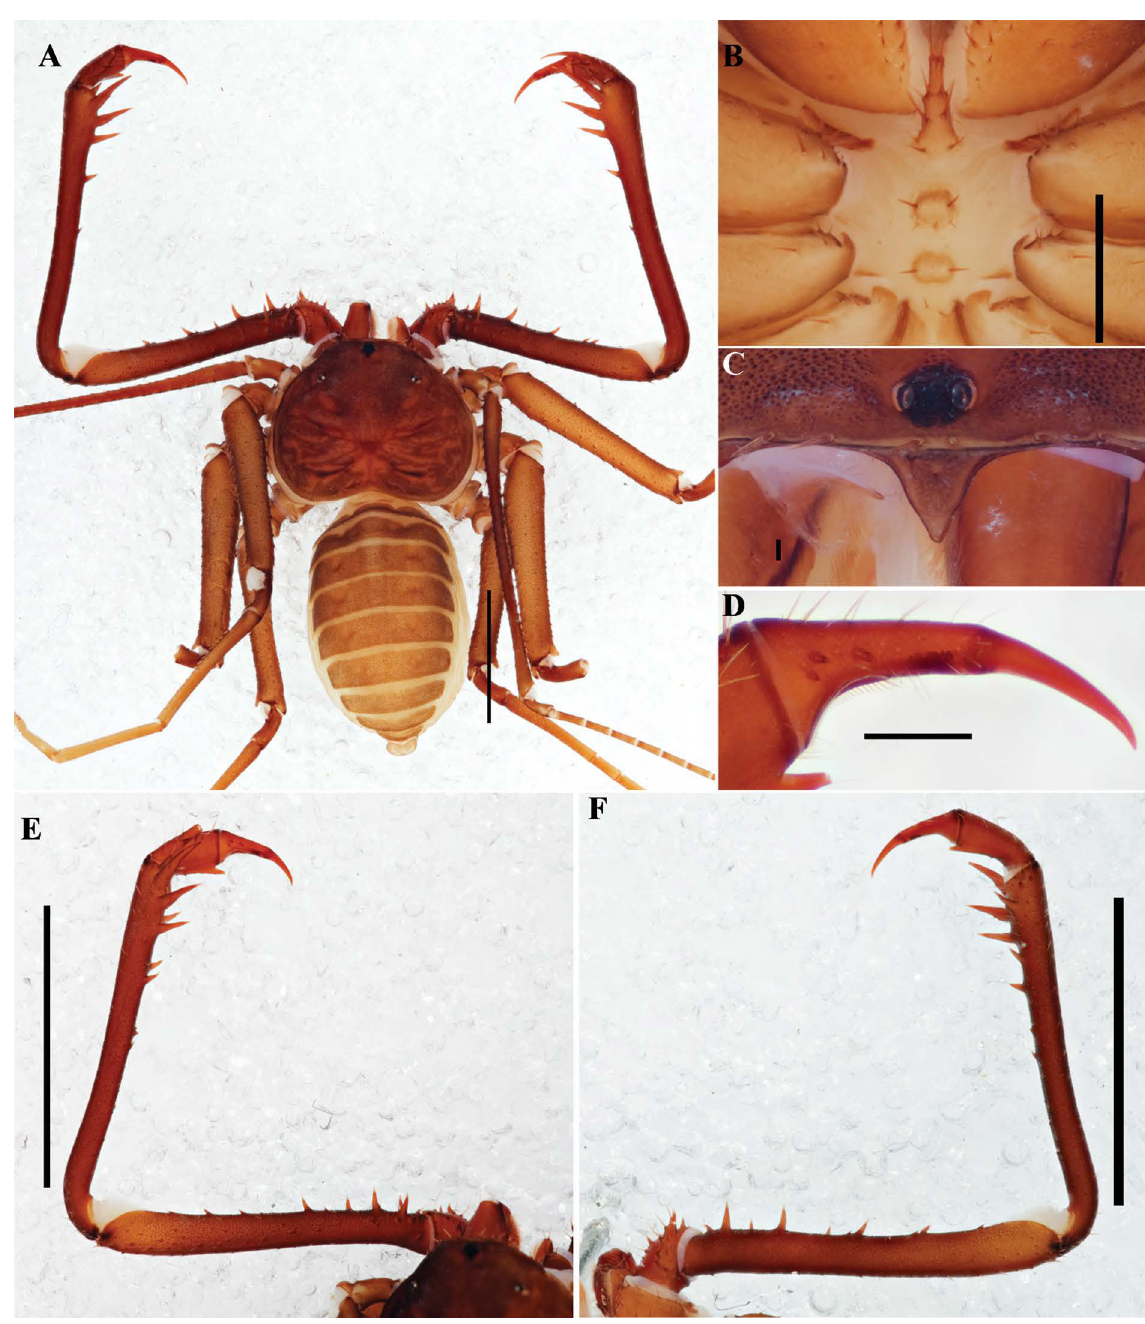
Fig. 75. Charinus sooretama sp. nov. (MNRJ 9245), general morphology, ♀. A . Habitus, dorsal view. B . Sternum, ventral view. C . Frontal process. D . Pedipalp tarsus, frontal view. E . Pedipalp, dorsal view. F . Pedipalp, ventral view. Scale bars: A = 1 cm; B = 1 mm; C = 0.1 mm; D = 0.5 mm; E–F =